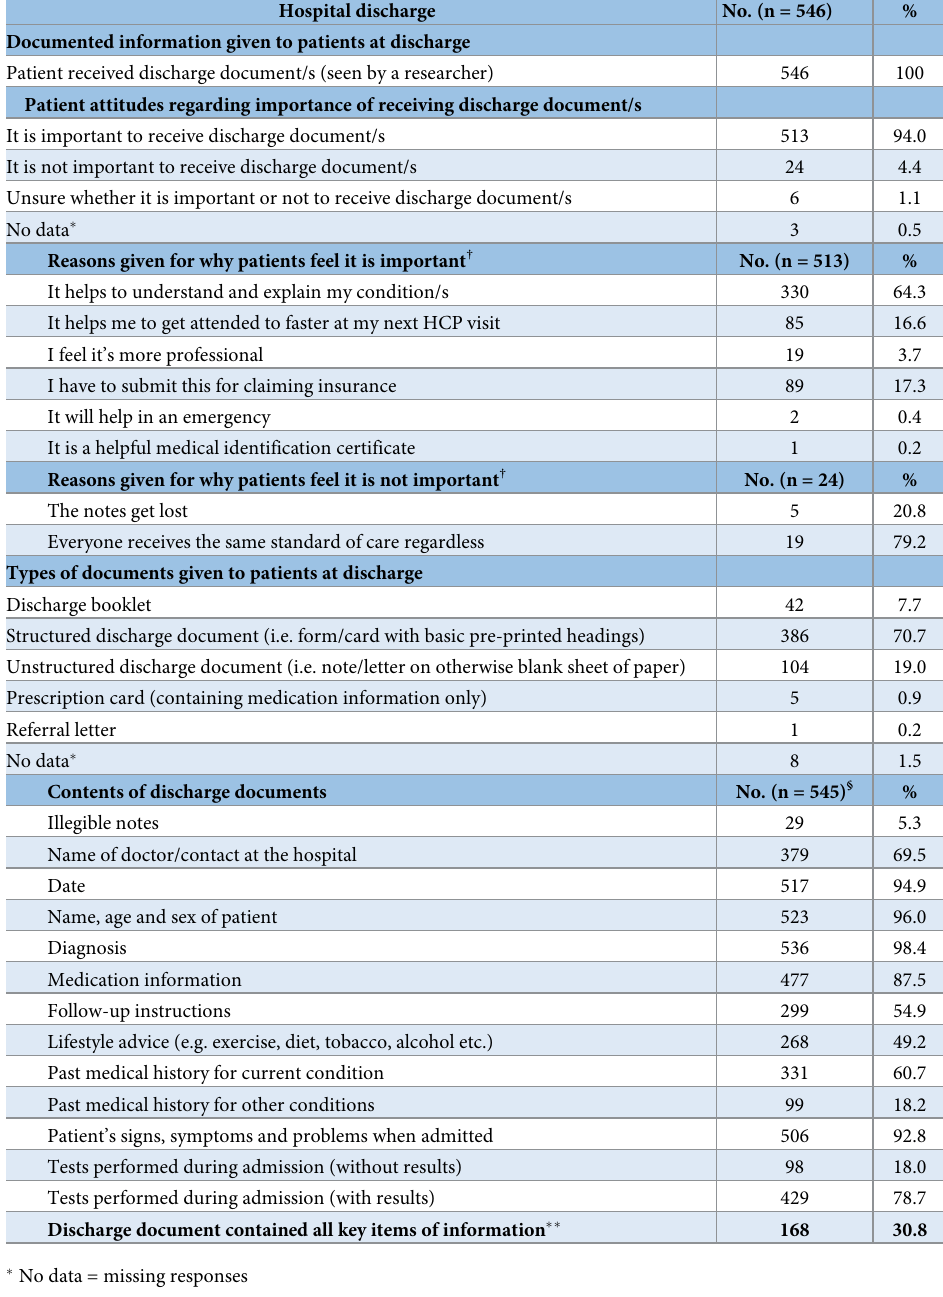
Table 3. Documented discharge